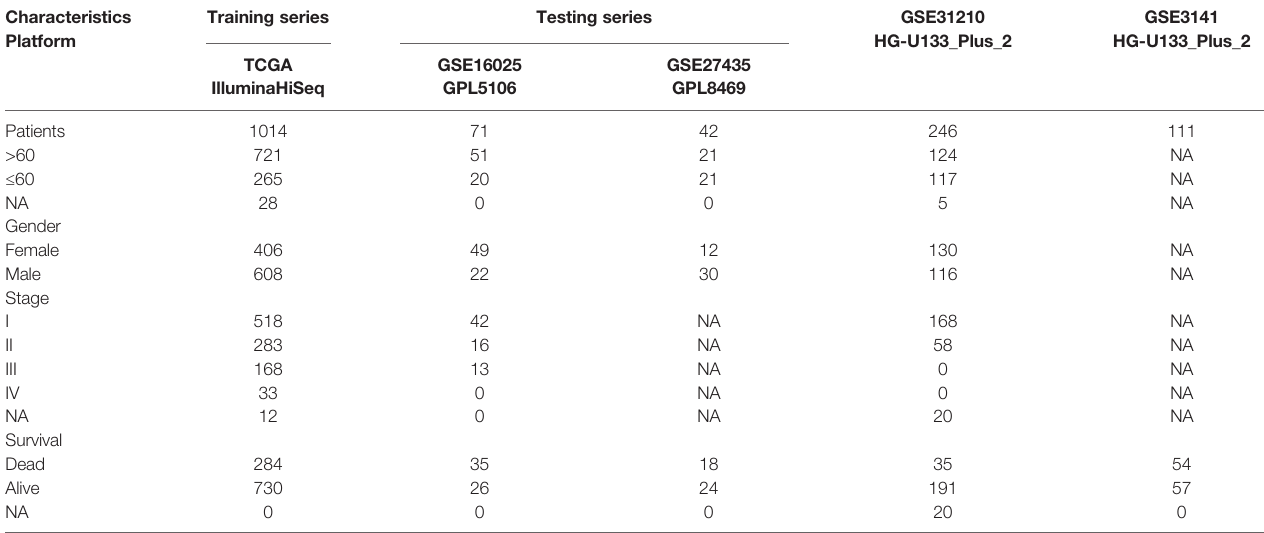
TABLE 1 | Clinicopathological characteristics of NSCLC patients in this study. Characteristics